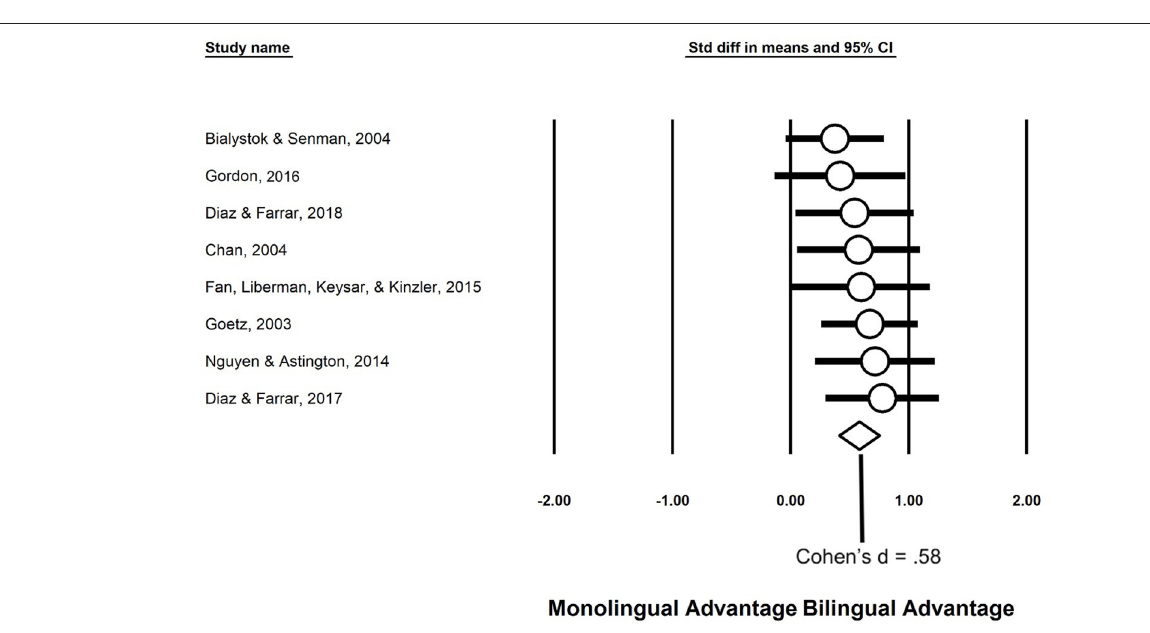
Frontiers in Communication |